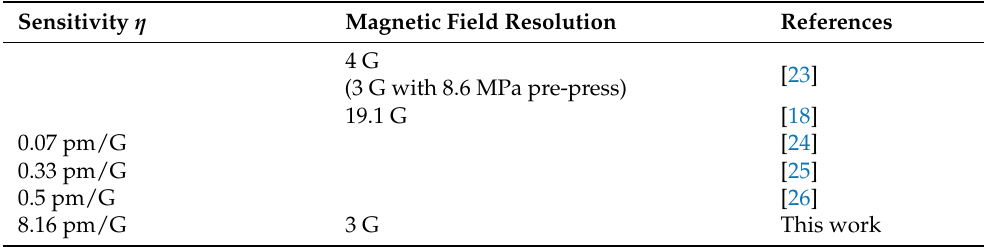
Table 1. Magnetic measurement comparison of some fiber grating sensor systems. Sensitivity